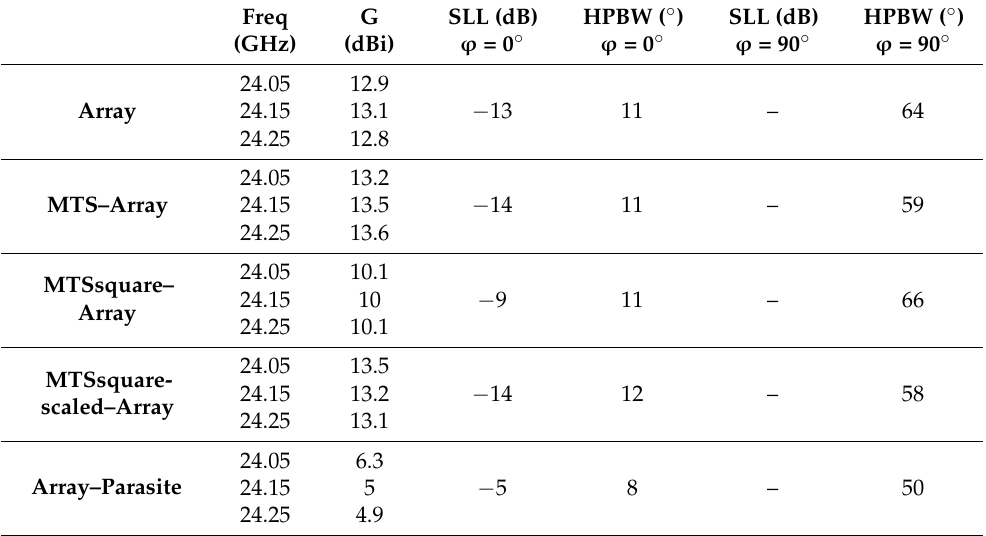
Table 2. Radiation properties results obtained in measurements for the array antenna alone and combined with metasurfaces and